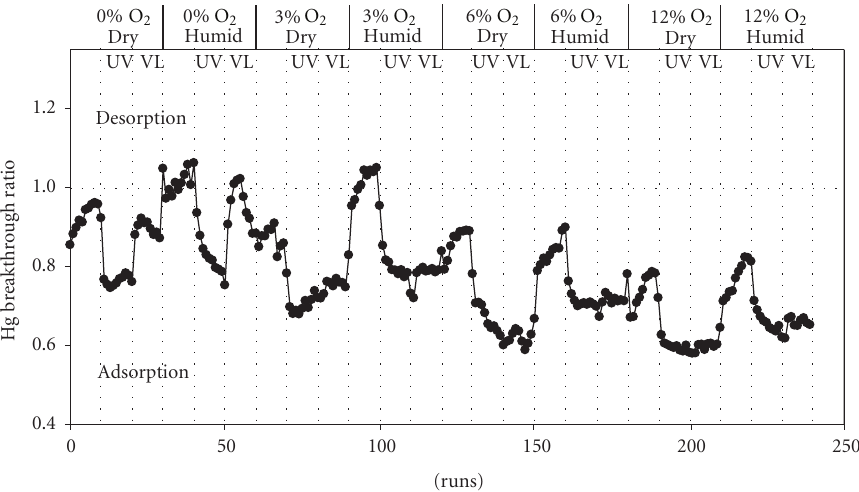
Figure 7: Hg breakthrough ratio of Al-doped TiO 2 in the continuous adsorption experiment under various test